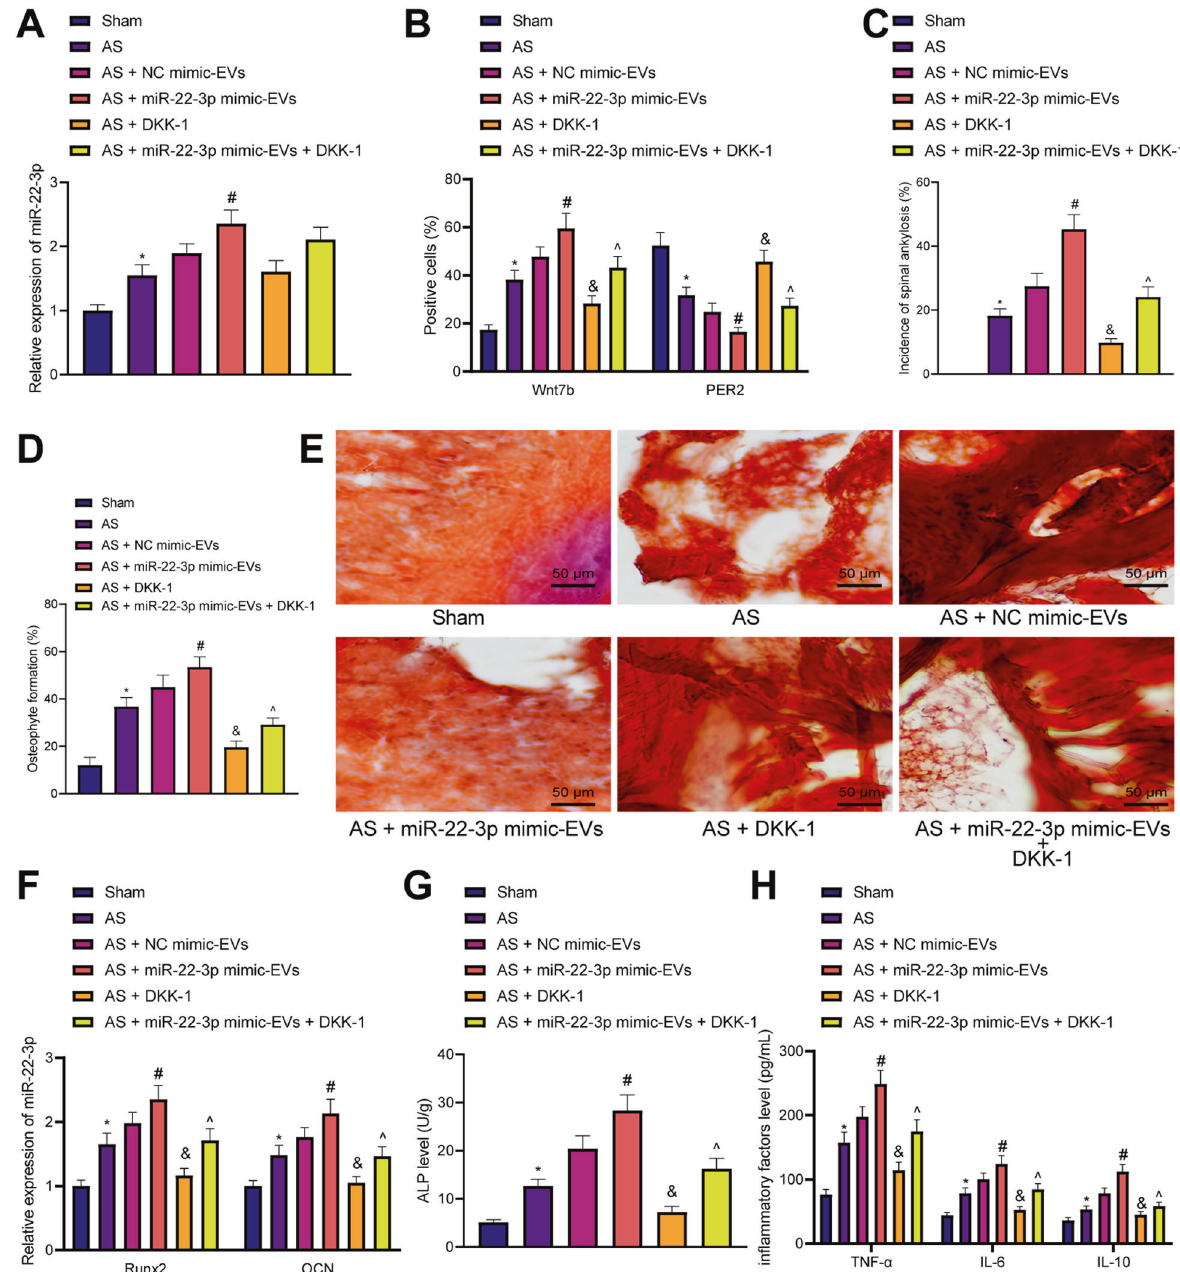
Fig. 7 miR-22-3p shuttled by M2-EVs induced pathological osteogenesis in AS mice via the PER2/Wnt/ β -catenin signaling. AS mice were treated with miR-22-3p mimic-EVs, DKK-1, or both. A miR-22-3p expression in the spinal tissues of AS mice determined using RT-qPCR. B PER2- and Wnt7b-positive cells in the spinal tissues of AS mice determined by immunohistochemical staining. C Micro-CT analysis of bone bridges (spine ankylosis) and ectopic new bone-formation rate in AS mice. D Vertebral osteophyte formation in AS mice observed using H&E staining. E Bone-bridge fusion between the vertebrae of AS mice detected using Alizarin red staining (scale bar = 50 μ m). F Expression of Runx2 and OCN in the spinal tissues of AS mice measured using RT-qPCR. G ALP content in the serum of AS mice detected by sodium diphenyl phosphate microplate assay. H Levels of in fl ammatory factors IL-6, IL-10, and TNF- α in the serum of AS mice measured by ELISA. * p < 0.05 vs . sham-operated mice, # p < 0.05 vs. AS mice injected with NC mimic-EVs, and p < 0.05 vs. AS mice, ^ p < 0.05 vs. AS mice injected with miR-22-3p mimic-EVs. n =